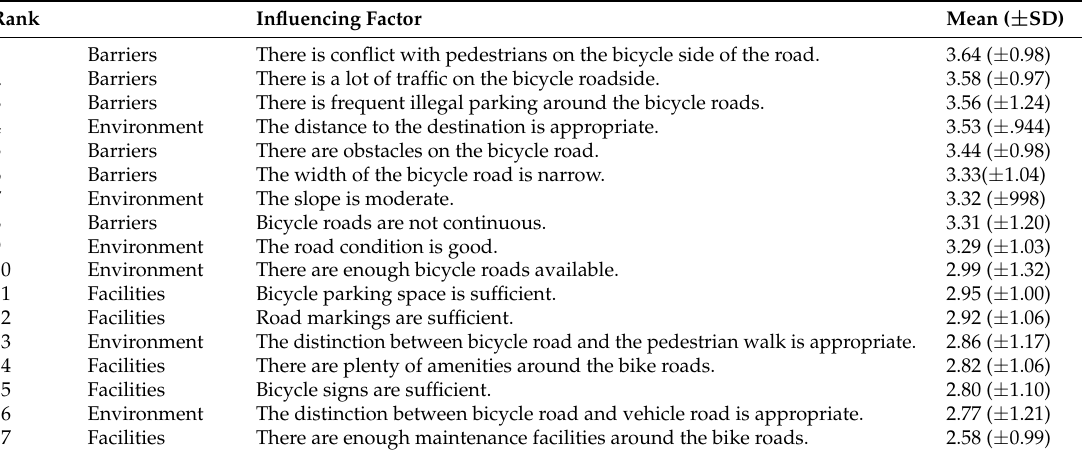
Table 3. Factors influencing bicycle road use in Seoul